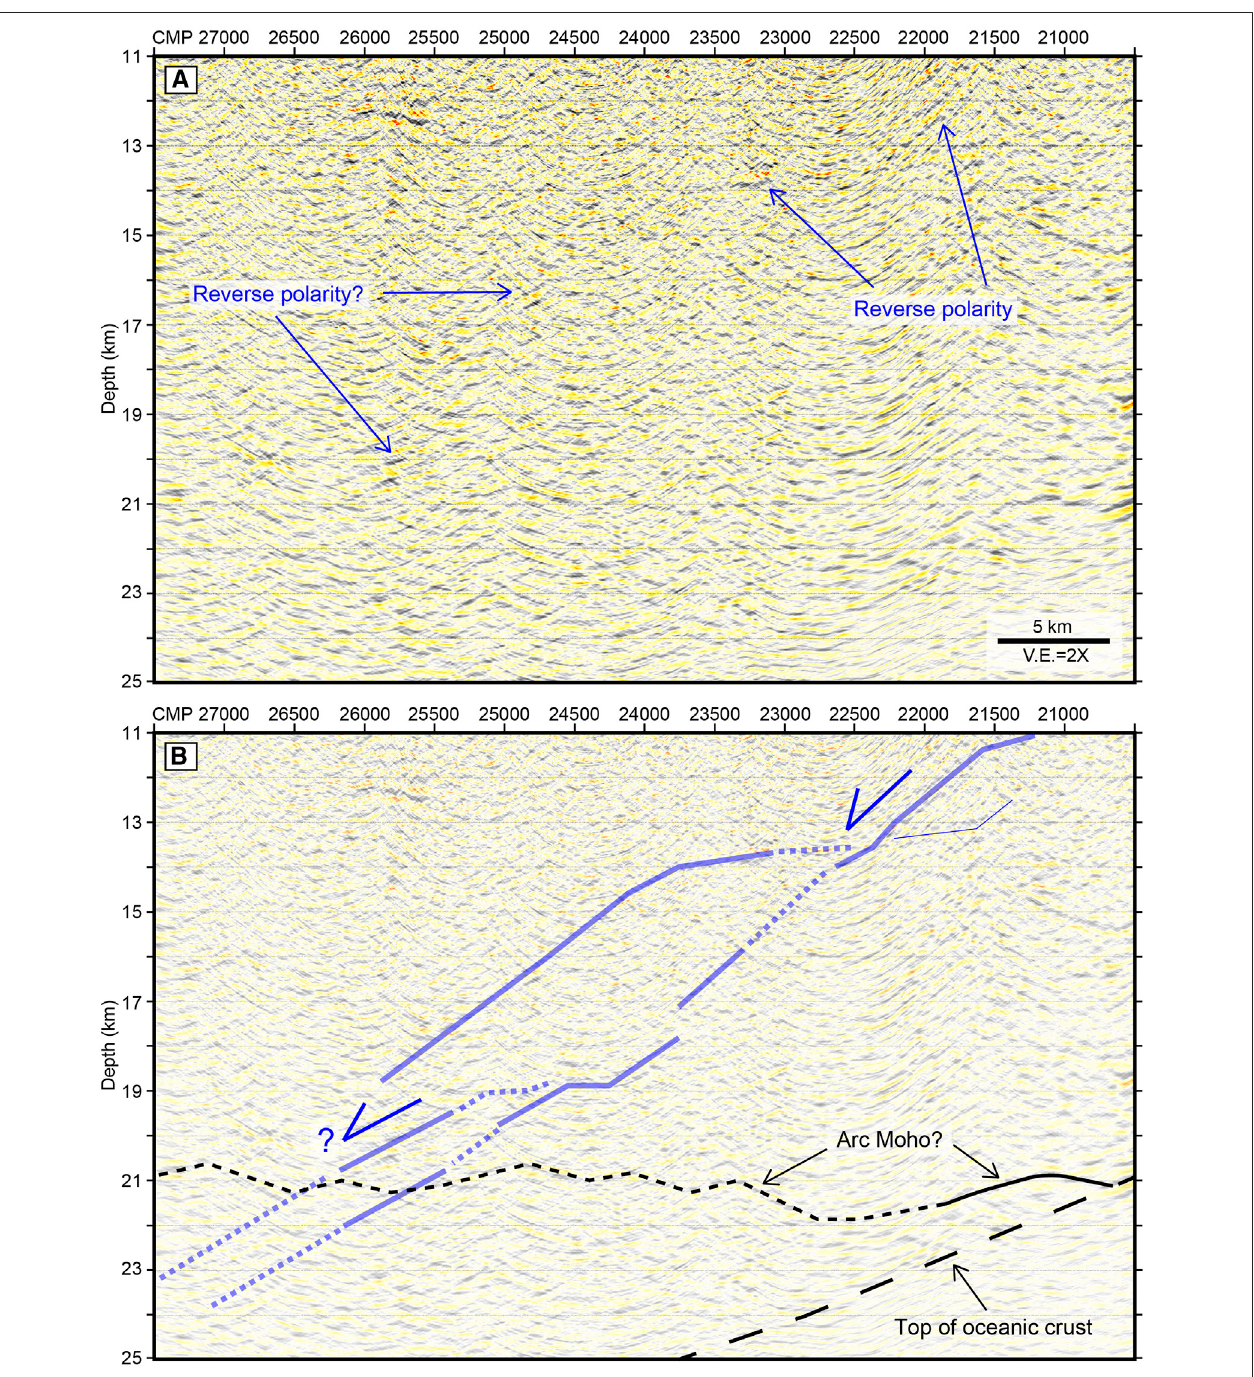
FIGURE 5 | Enlarged PSDM section on line D6 and its interpretation showing deep extension of the landward-dipping normal fault F1 in the middle slope region. Thesectionlocationispresentedin Figure2B . (A) UninterpretedPSDMsection.Reverse-polarityre fl ections(black – red – black)offaultF1. (B) InterpretedPSDMsection.